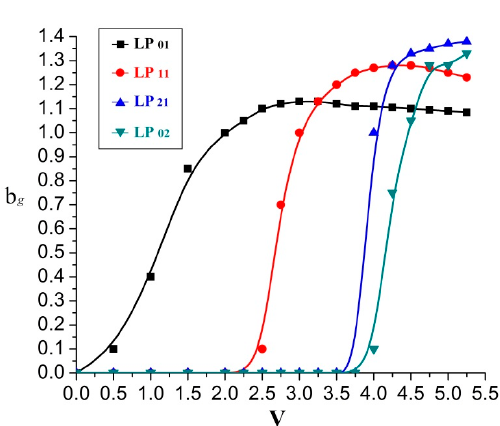
Figure 1. Normalized group delay b g vs. the normalized frequency V .